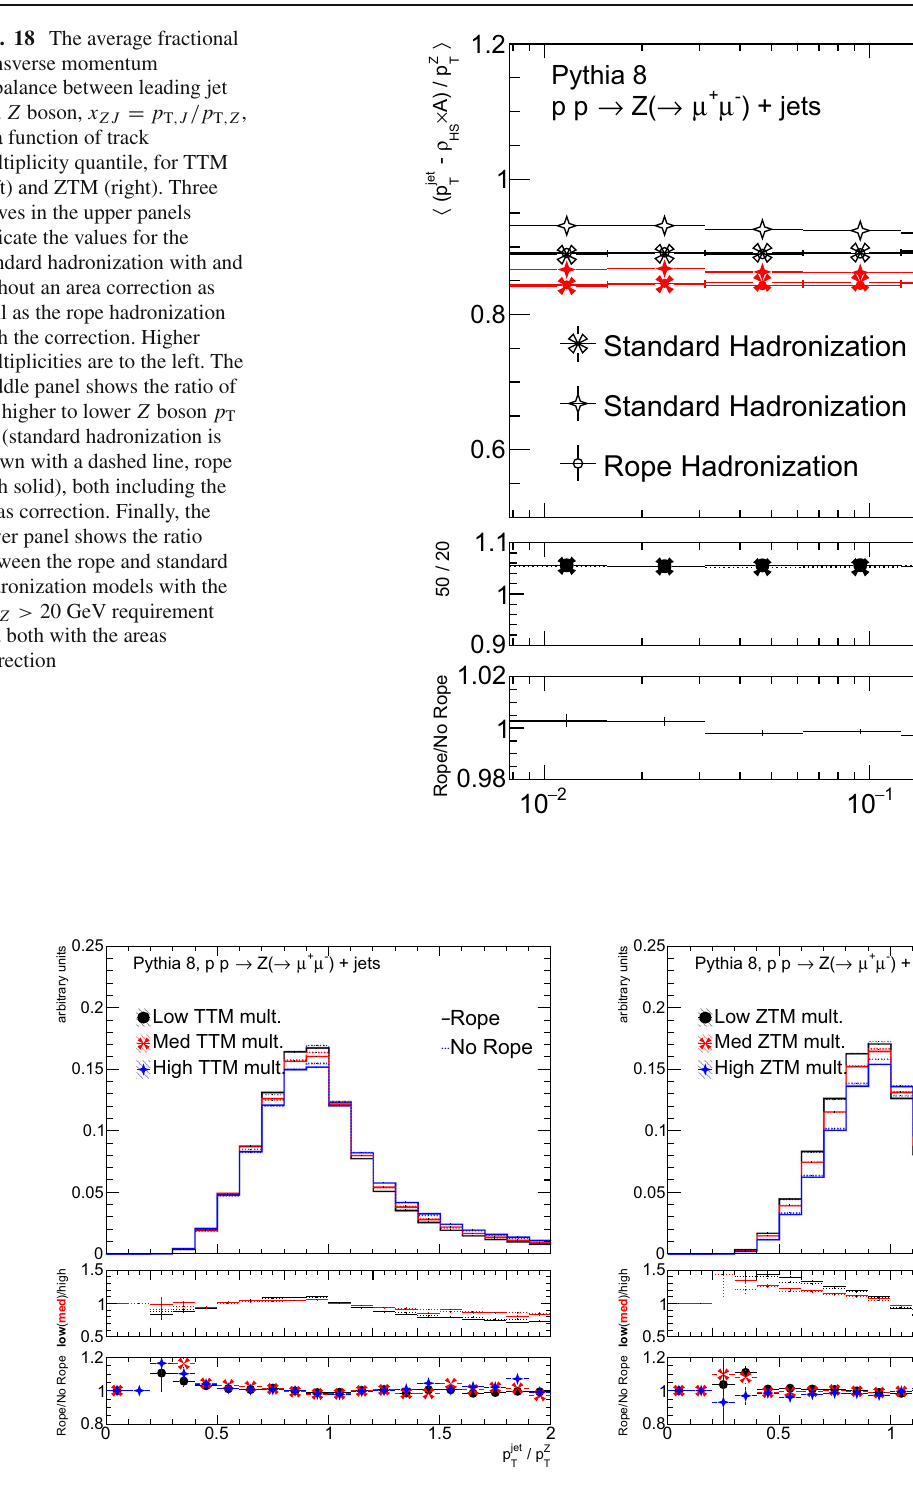
Fig. 19 The distribution of the ratio x ZJ = p T , J / p T , Z for three bins of the TTM (left) and ZTM (right) multiplicity: the 50th, 75th, and 90th percentile. The middle panel shows the ratio of the distribution for high to low multiplicity for both hadronization models (standard hadroniza-